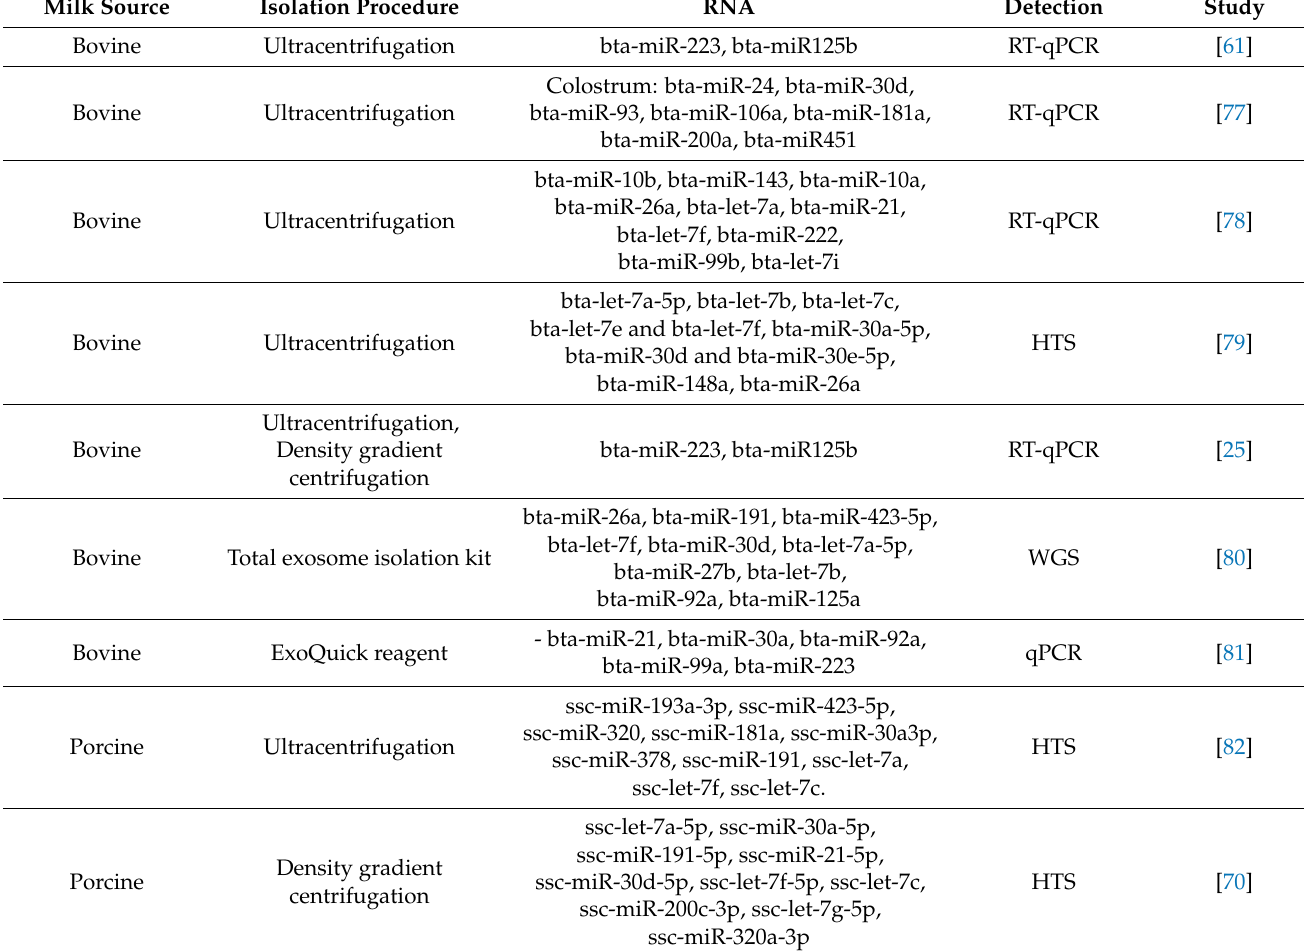
Table 5. Main microRNAs identified in isolated extracellular vesicles from livestock